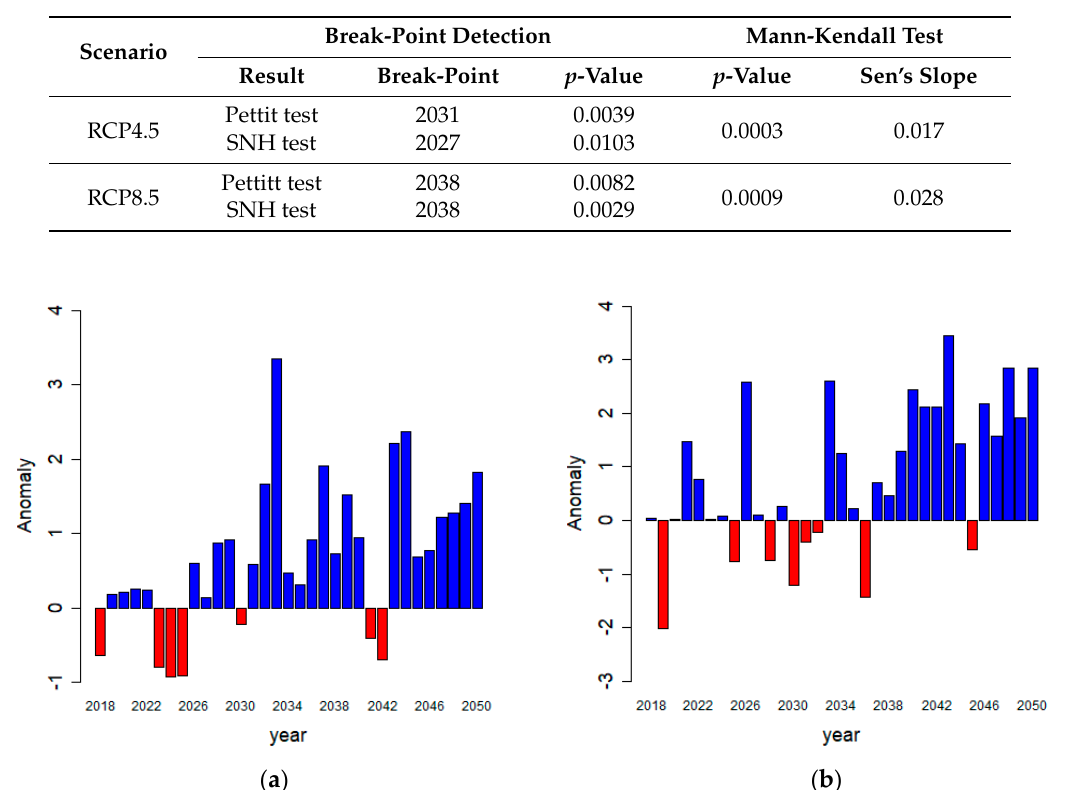
Table 5. Results of Mann-Kendall test on annual temperature under RCP4.5 and RCP8.5.